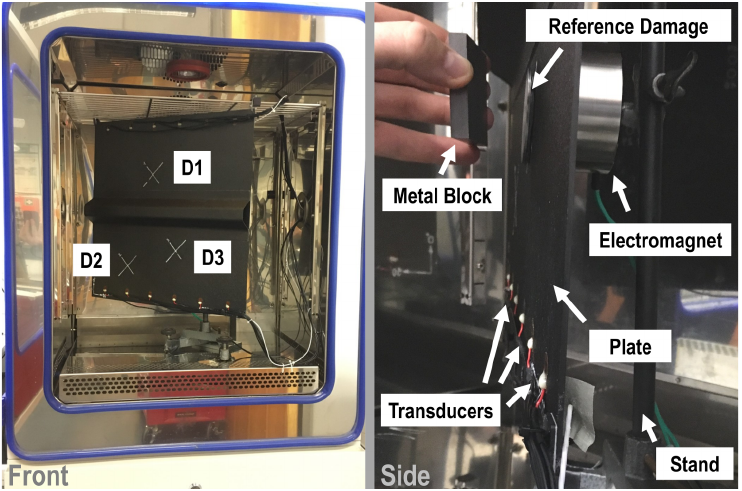
Figure 7. Illustration of the experimental setup arranged in a climatic chamber for the measurement campaign. The plate is instrumented with several transducers and damaged by artificial